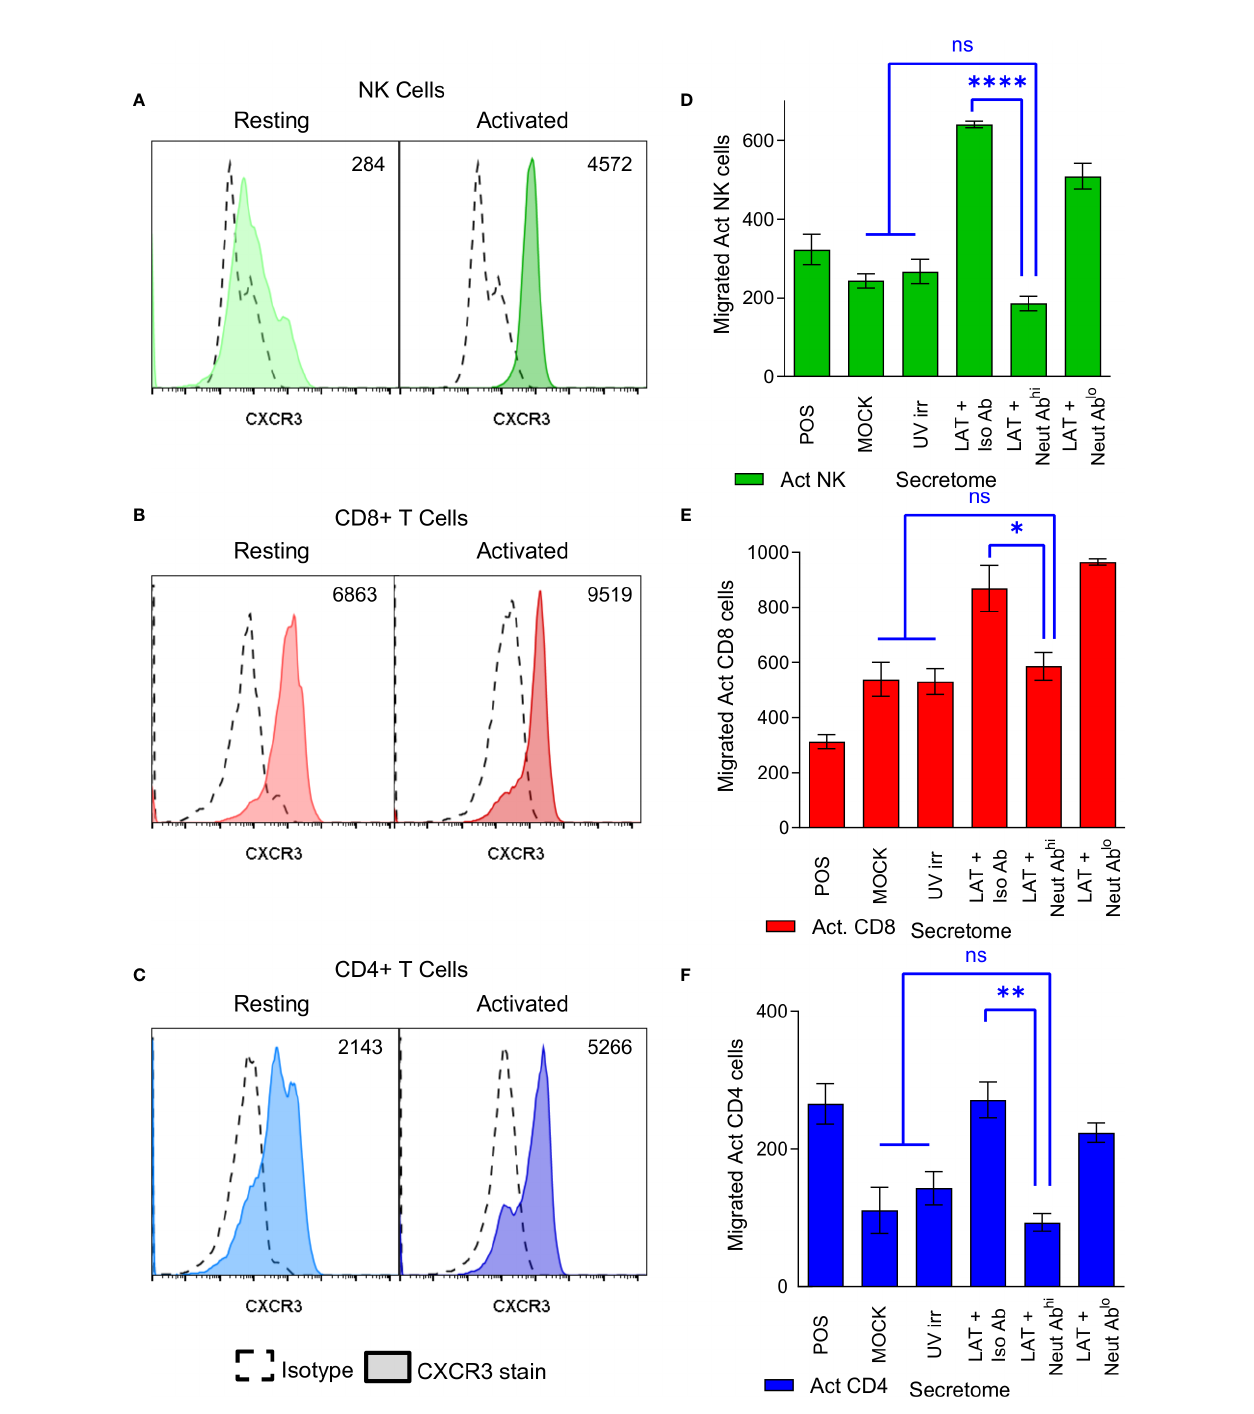
FIGURE 4 | CXCR3 is upregulated on activated immune cell subsets and neutralization of CXCL10 abrogates migration of these cells. Histograms from fl ow cytometry analysis of CXCR3 expression on resting (left-hand histogram) and activated (right-hand histogram) NK cells (A) , CD8+ T cells (B) and CD4+ T cells (C) showing increased expression of CXCR3 on activated cell subsets (value shown on graph normalized geo-mean of CXCR3 expression for all cells analyzed). Representative results from 6 individual donors shown. Transwell migration assays were performed on the latent infected monocyte secretomes in the presence of CXCL10 neutralizing antibody or isotype controls showing that neutralization of CXCL10 signi fi cantly abrogates migration of activated NK cells (D) , CD8+ T cells (E) and CD4+ T cells (F) (1-way ANOVA with Sidak ’ s multiple comparison results shown in blue on the graphs; NK p<0.0001****, CD8 p=0.0488* and CD4 p=0.0032**, non-signi fi cant (ns) comparisons are also